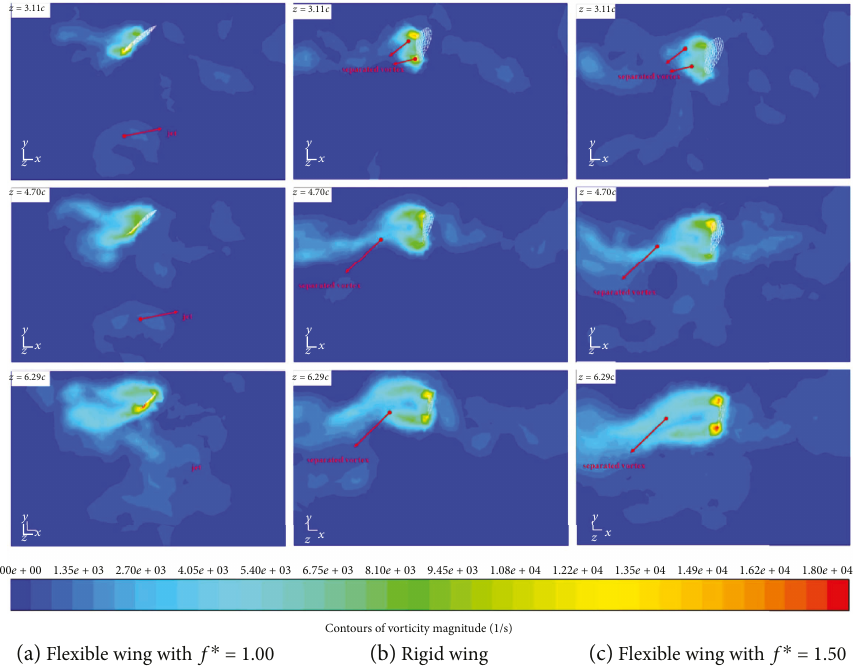
f⁎ (a) Flexible wing with = 1.00 (b) Rigid wing (c) Flexible wing with Figure 10: The vortex of the rigid and fl exible wing with f ∗ = 1 00 and 1.50 at t =11.30 T and z =3.11 c , 4.70 c , and 6.29 c